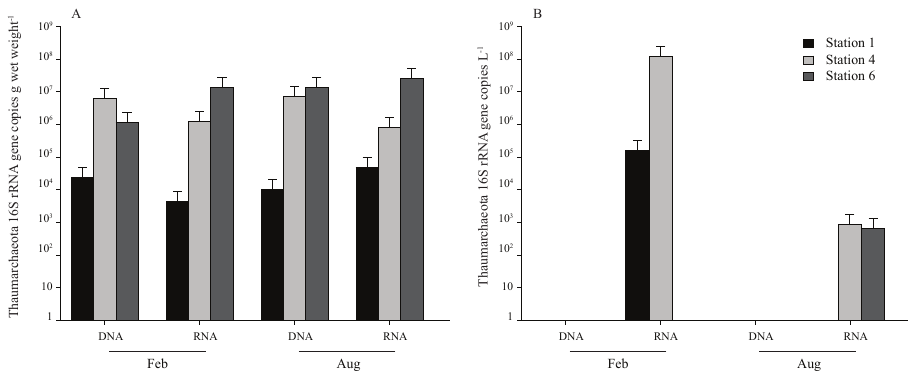
Fig. 4. Thaumarchaeota 16S rRNA gene copies (A) in surface sediment (gwetweight − 1 ) and (B) in surface water (L − 1 ) from selected stations in February (Feb) and August (Aug). Logarithmic scale was used. Detection limit of the analysis, 220copiesg − 1 and 30copiesL − 1 . Table 3. Composition (% of total clones sequenced) of archaeal 16S rRNA gene transcript clone libraries retrieved from stations 4 and 6 – surface sediments from August 2010 and surface waters from February 2010. Archaeal groups Surface water – February Sediment –